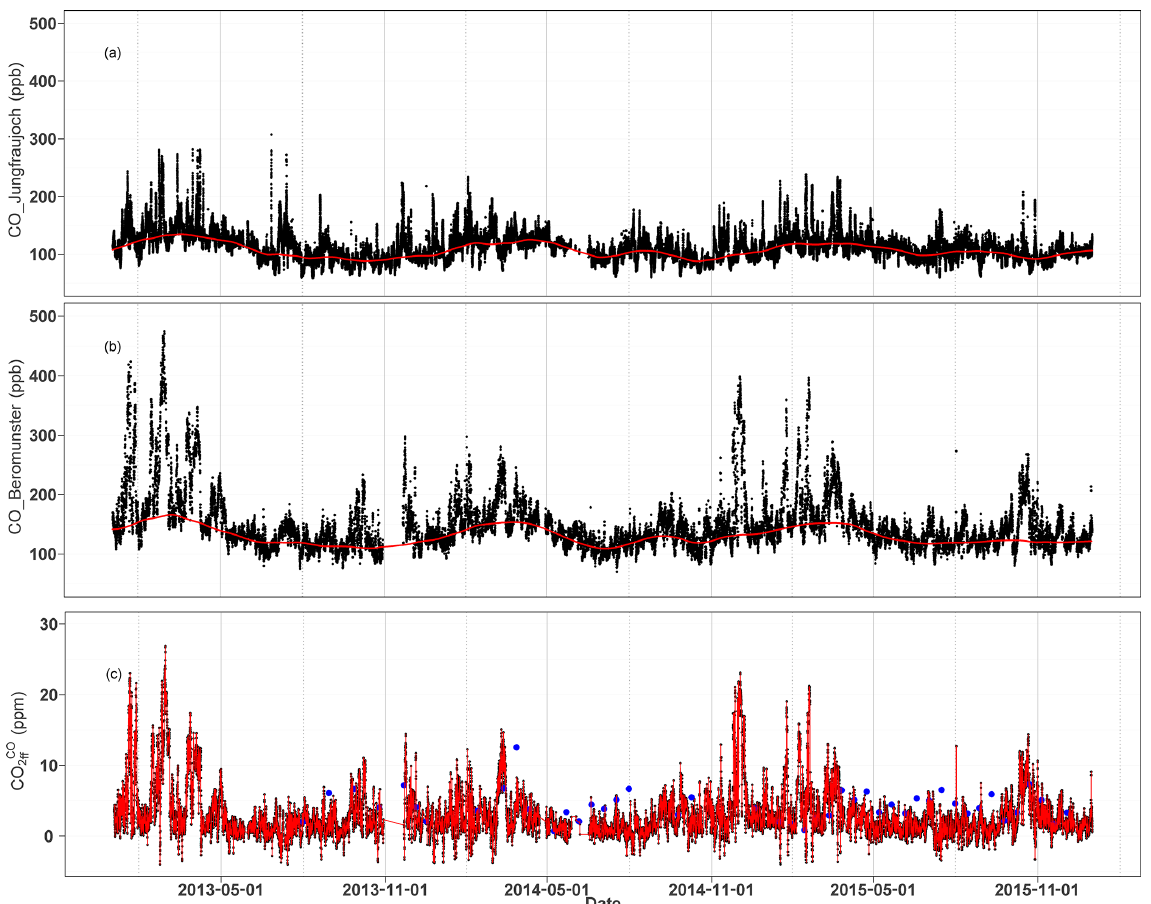
Figure 4. Time series of hourly mean CO mixing ratios measured at Jungfraujoch (a) and Beromünster (b) sites, with the red curve showing the estimated background values using the REBS method with 60-day window. Panel (c) shows the hourly mean CO 2ff time series calculated using the emission ratios determined from radiocarbon measurements, and the CO enhancements at Beromünster over the Jungfraujoch background based on Eq. (7). The blue dots in panel (c) shows the CO 2ff values determined using the radiocarbon